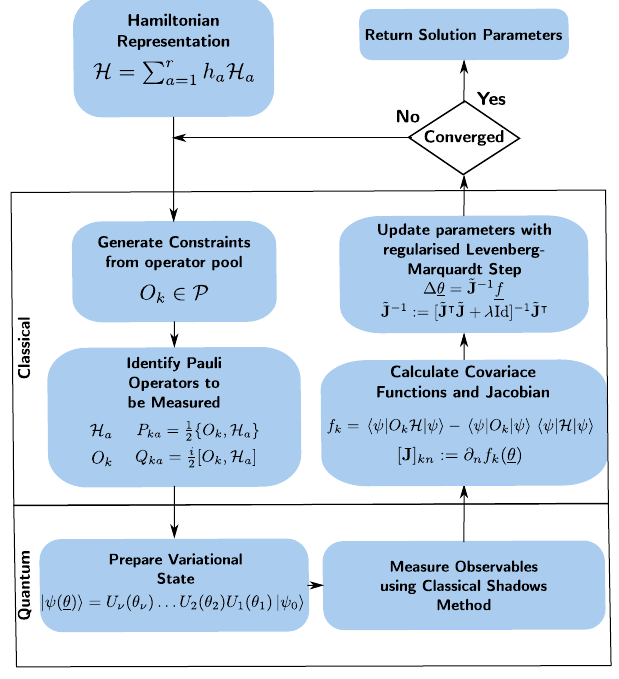
FIG. 2. Flowchart depicting the CoVaR algorithm showing the separation between quantum and classical